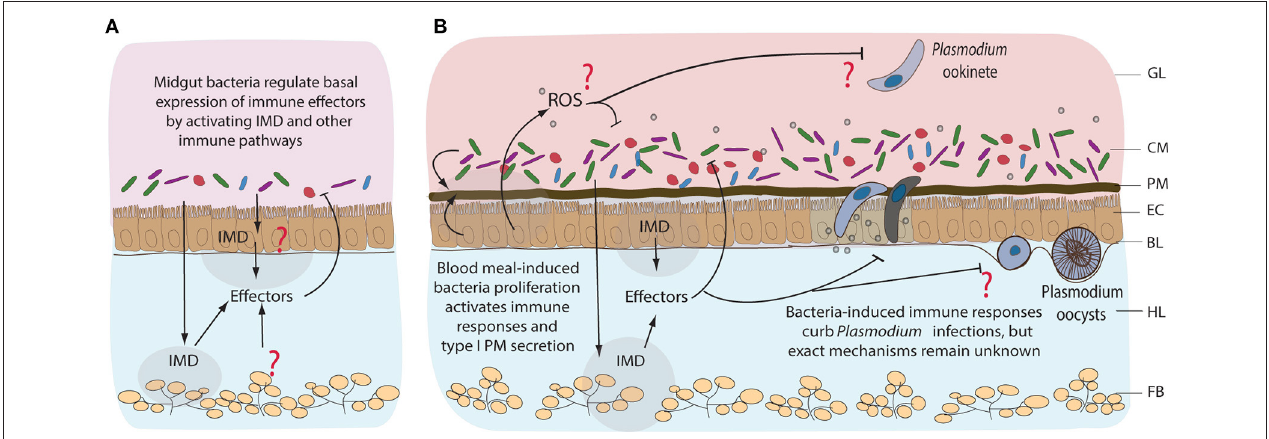
FIGURE 4 | Immune responses of mosquitoes to midgut bacteria and to Plasmodium parasites. Immune responses to resident bacteria before (A) and after blood feeding (B) . Proliferation of the midgut bacteria is regulated mainly by IMD pathway, however the tissue specificity of its expression remains unknown. Immune responses could be coming from the gut, hemocytes (mosquito blood cells), or fat body (nutrient storage and immune tissue). Involvement of other immune pathways, including reactive oxygen species (ROS), in response to midgut bacteria is not well-characterized. Blood feeding-induced bacteria proliferation activates immune responses that also curb the invasion of Plasmodium, mainly at the ookinete stage of development. GL, gut lumen; CM, complex microbiota; PM, peritrophic matrix; EC, epithelial cells; BL, basal lamina; HL, hemolymph; FB, fat